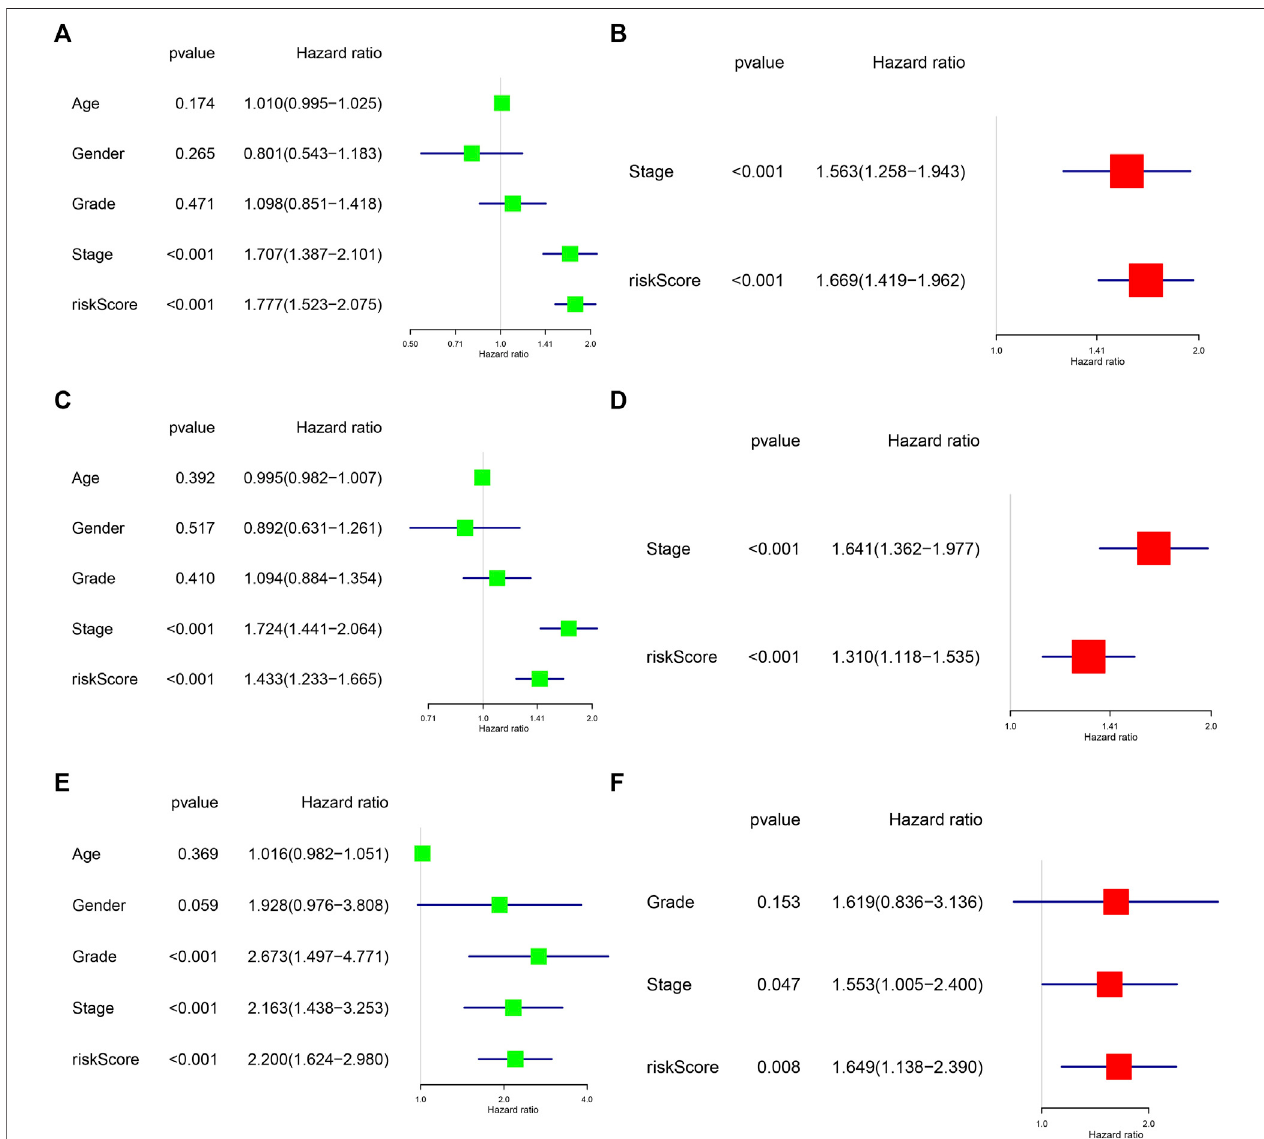
FIGURE 5 | Analysis ofthe independent prognostic value of riskscores in HCC. (A) Univariate regression analysis of clinical characteristics and riskscore affecting patient OS in the TCGA cohort. (B) Multivariate regression analysis of clinical characteristics and risk score affecting patient OS in the TCGA cohort. (C) Univariate regressionanalysisofclinicalcharacteristicsandriskscoreaffectingpatientDFSintheTCGAcohort. (D) Multivariateregressionanalysisofclinicalcharacteristicsandrisk score affecting patient DFS in the TCGA cohort. (E) Univariate regression analysis of clinical characteristics and risk score affecting patient OS in the ICGC cohort. (F) Multivariate regression analysis of clinical characteristics and risk score affecting patient OS in the ICGC cohort.